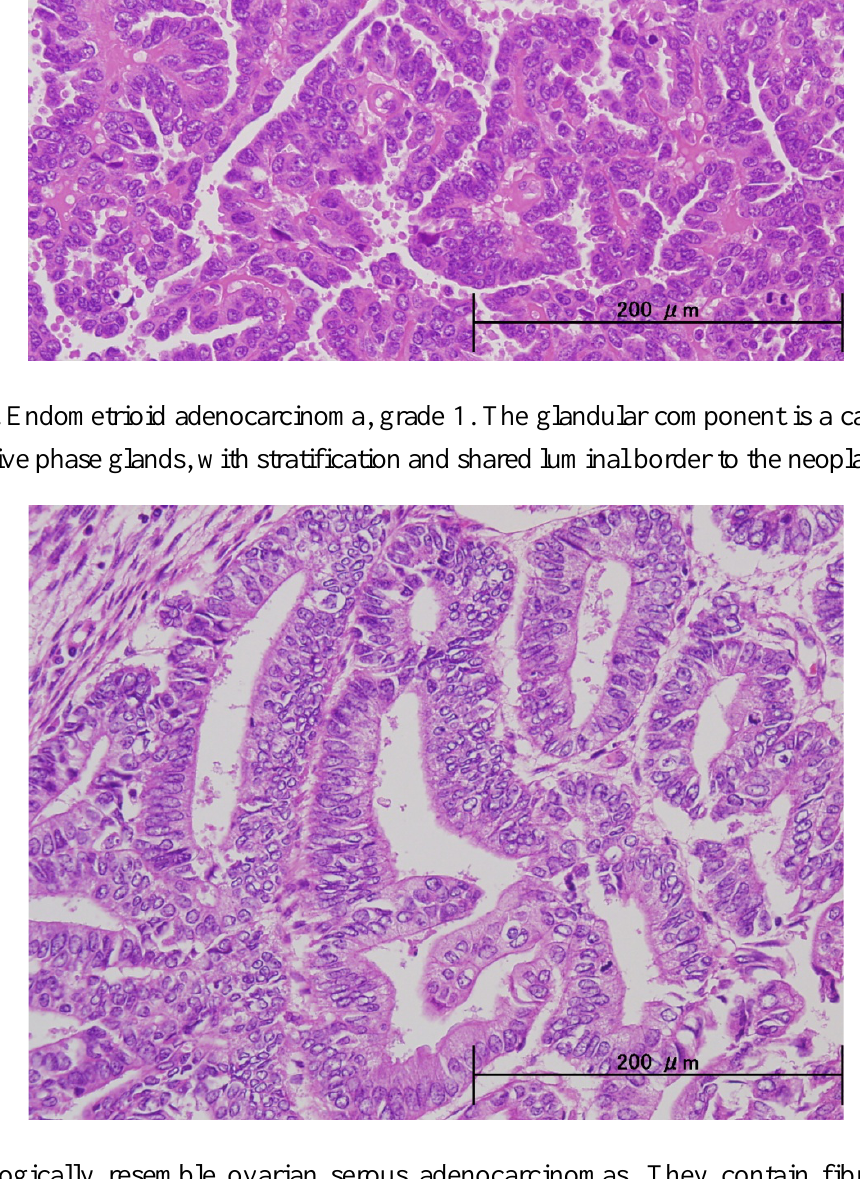
ESCs histologically resemble ovarian serous adenocarcinomas. They contain fibrous stroma and show a papillary pattern of proliferation. Tumor cells are pleomorphic, have prominent nuclear atypia, high N/C ratios, distinctive nucleoli, and frequent nuclear fission. Sixty percent of ESCs contain psammoma bodies. Other pathognomonic cellular features include a ballooned or hobnail-like nucleus and stromal